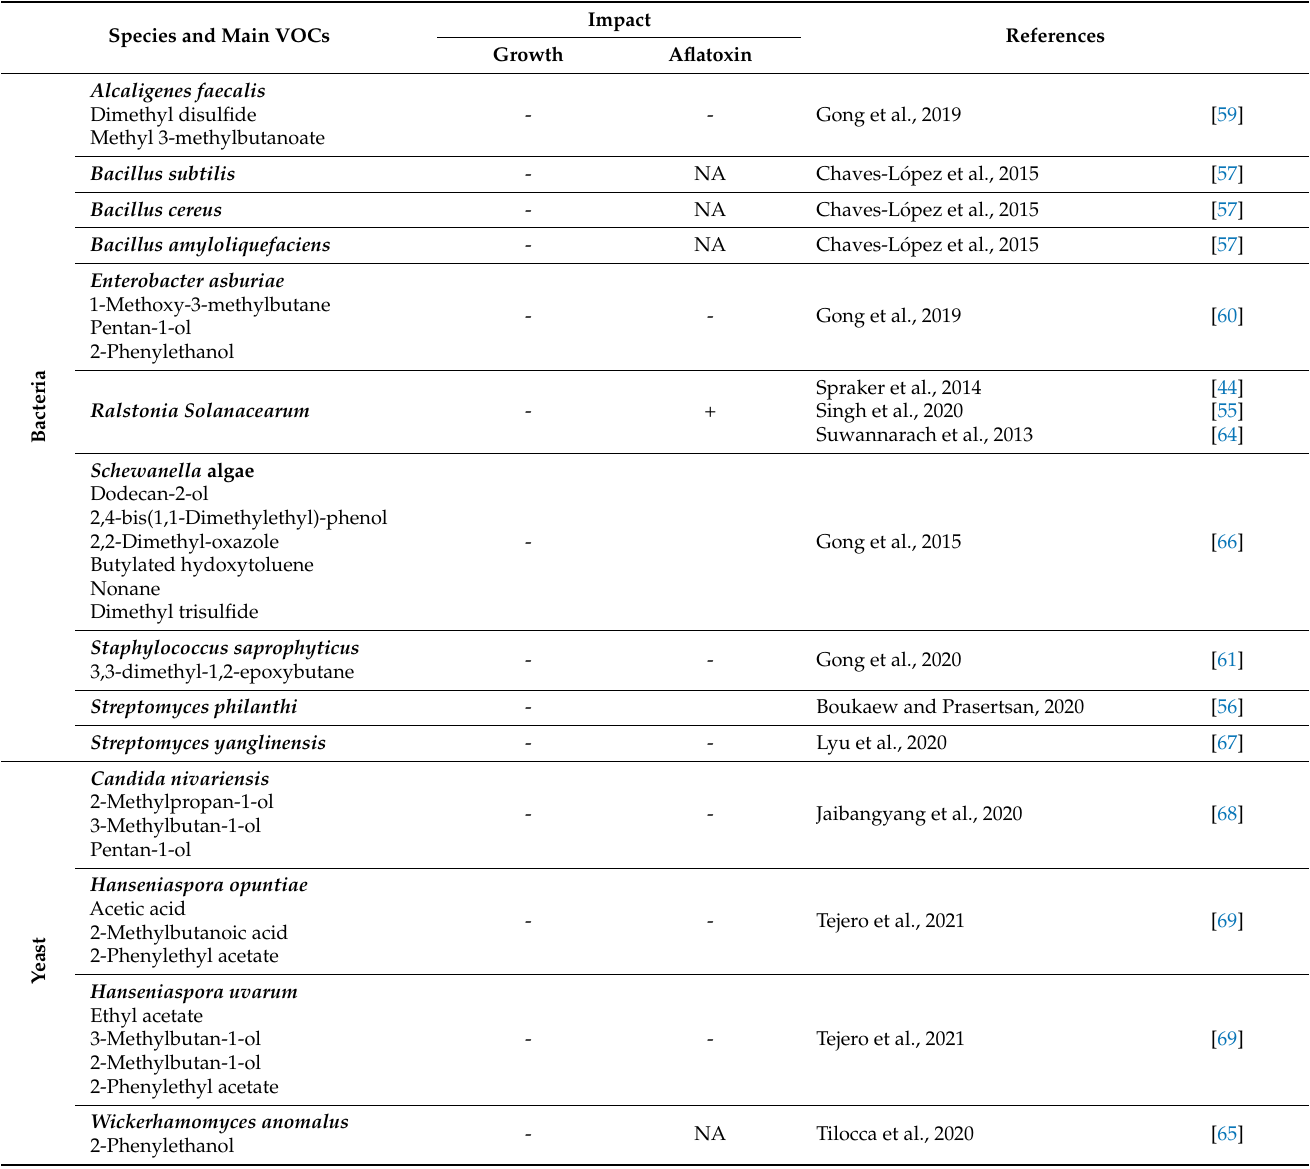
Table 3. Volatolomes and their major compounds when identified from bacteria, yeast and fungi impacting A. flavus growth and/or its AFB1 production without physical